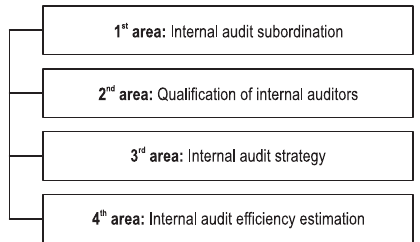
Fig. 2. Areas of internal audit implementation